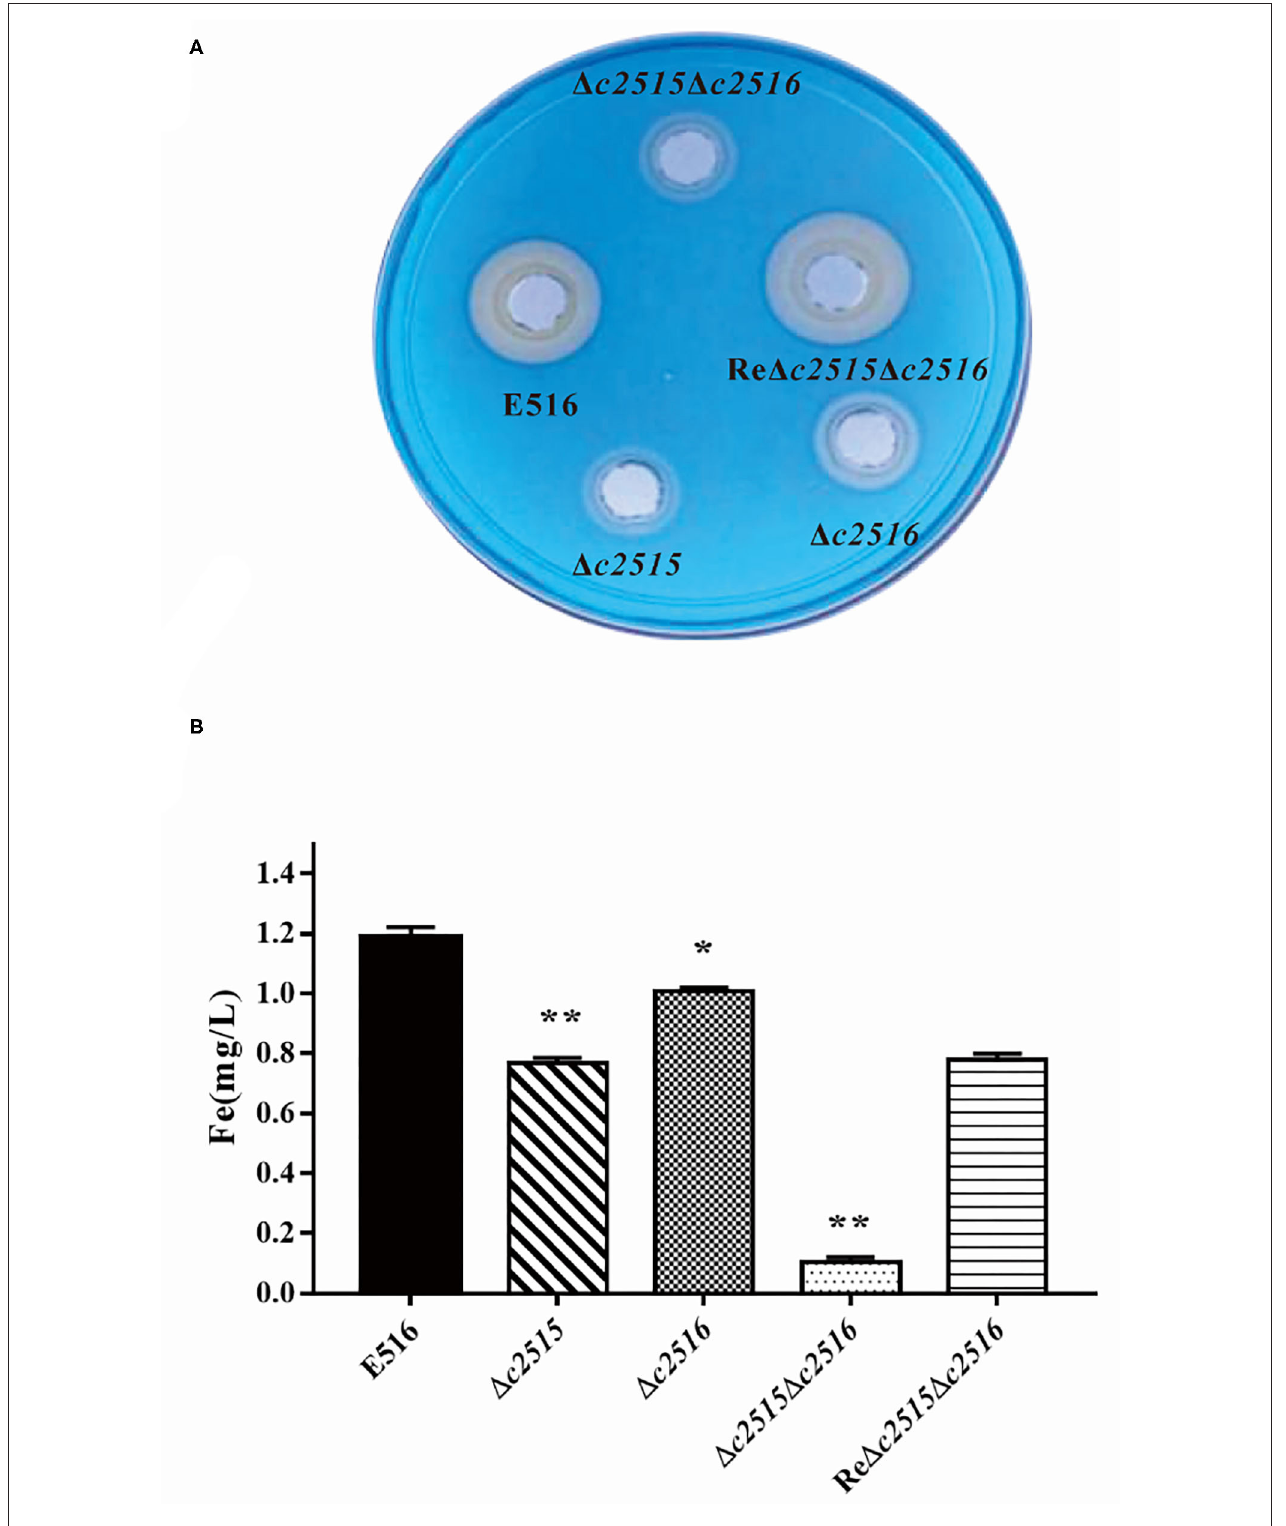
FIGURE 3 | The iron uptake ability between the WT and the mutants strains. (A) The CAS agar diffusion assay. Strains E516 and Re 1 c2515 1 c2516 complementation rendered orange halos larger than that of the mutants. (B) The intracellular iron levels of the WT, mutant, and complemented strains. The bacterial strains were cultured in iron-depleted MM9 medium to the log phase. The cellular iron contents of the WT, mutant, and complemented strains were determined using an iron colorimetric assay kit (* P < 0.05,** P < 0.01).